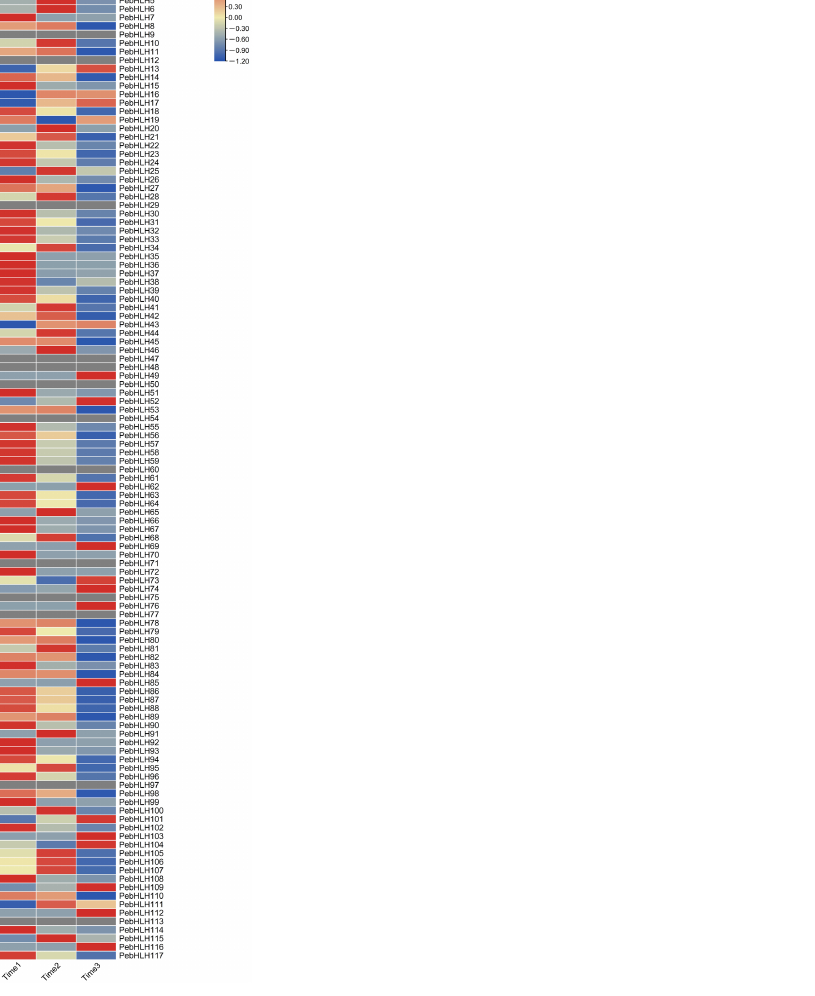
Figure 9. Differential expression of PebHLHs during 3 fruit ripening periods (Table